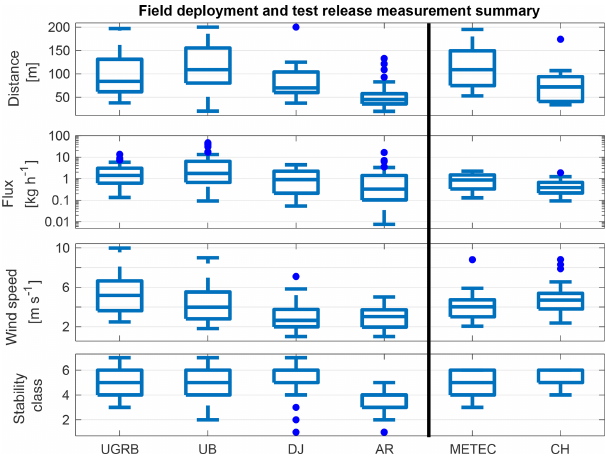
Figure 13. Summary of accepted OTM 33A measurements from field deployments and test releases (right of vertical line). Basins from Robertson et al. (2017). Upper Green River Basin, Wyoming (UGRB), Uintah Basin, UT (UB), Denver–Julesburg Basin, CO (DJ), Fayetteville, Arkansas (AR). Mean statistics (from left to right) are as follows. Distance (m): 98, 114, 83, 51, 114, 78. Flux (kgh − 1 ): 2.41, 6.99, 1.51, 1.27, 0.51, 0.96. Mean wind speed (ms − 1 ): 5.3, 4.2, 3.1, 2.9, 4.1, 4.9. Stability class: 5.0, 4.9, 5.3, 3.5, 5.0, 5.4.